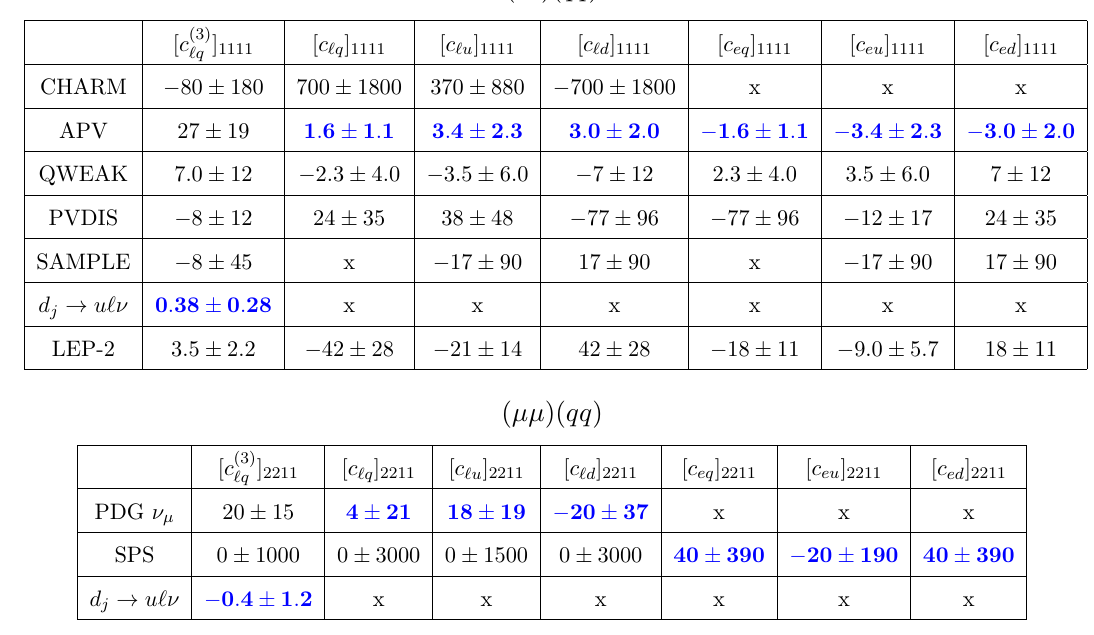
Table 5 . 68% C.L. constraints (in units of 10 (cid:0) 3 ) on chirality-conserving ( ee )( qq ) and ( (cid:22)(cid:22) )( qq ) operators from di(cid:11)erent precision experiments. The bounds are derived assuming that only one operator is present at a time. See table 4 and main text for further details about the di(cid:11)erent experiments. The best constraint in each case is highlighted in blue, while ‘x’ signals that the operator is not probed at tree level by that experiment or